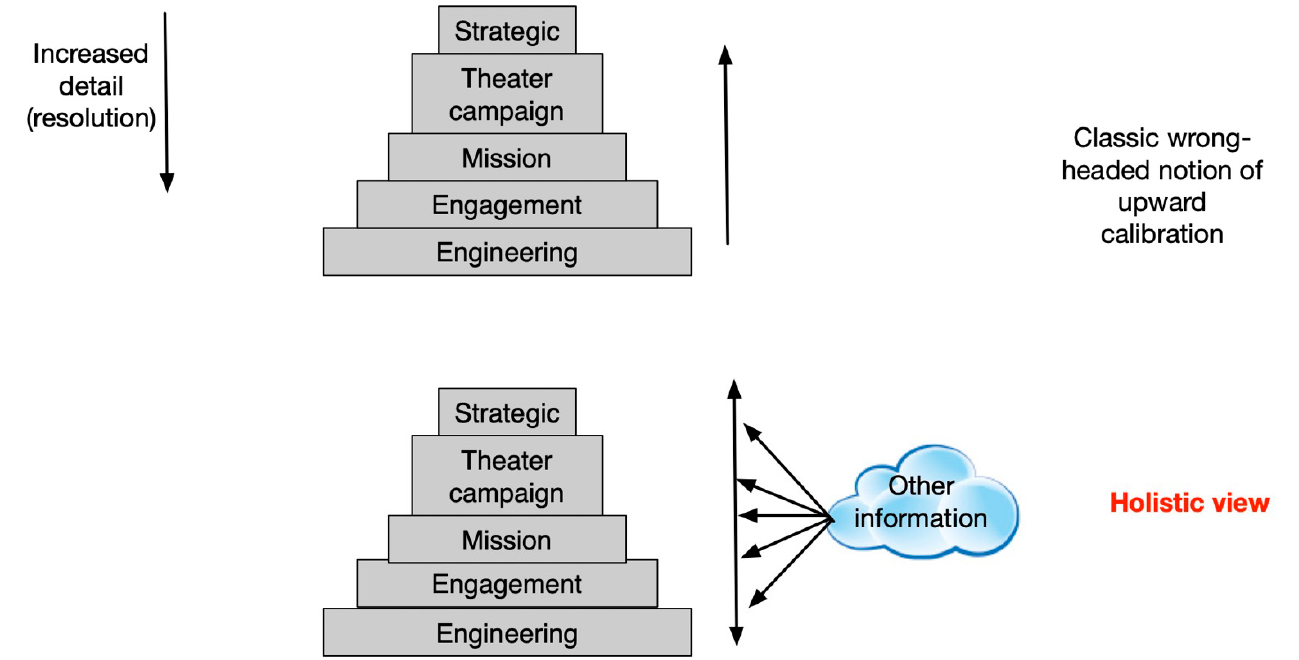
Figure 1. Objective: achieving consistency across combat models of varied resolution.